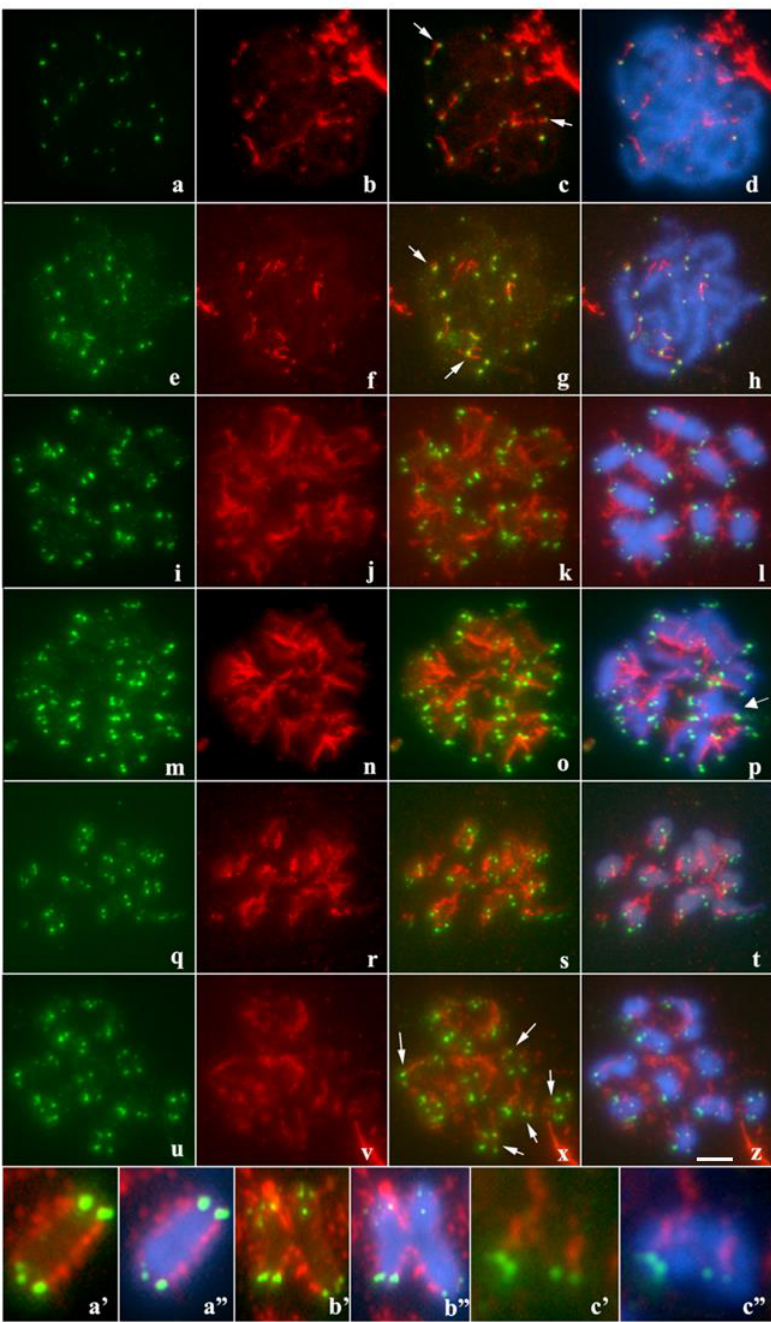
Figure 4. Immunodetection of tubulin along prophase I in T. maranhensis . In red tubulin and in green telomeres: ( a – d ) zygotene (arrows indicate union of telomeres and tubulin fibers); ( e – h ) pachytene (arrows indicate union of telomeres and tubulin fibers); ( i – l ) metaphase I; ( m – p ) anaphase I (arrow indicates quadrivalent). ( q – t ) metaphase II; ( u – z ) anaphase II (arrows indicate union of telomeres and tubulin fibers). Panel with enlarged bivalent ( a ’ , a ” ) and quadrivalent ( b ’ , b ” ) metaphase I; ( c ’ , c ” ) sister chromatids at the beginning of anaphase II. In a ’ – c ” tubulin (red), telomeres (green) and DAPI-stained chromosomes (blue). Bar: 10 µm.